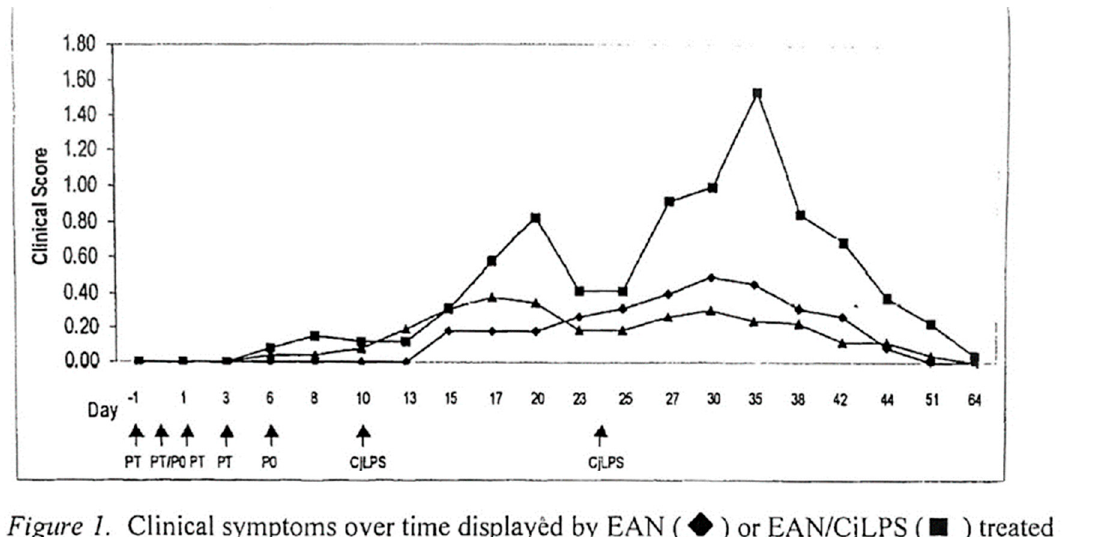
Figure 1. Experimental allergic neuritis (EAN) was induced in GM1 antibody transgenic mice (GM1Ab) by immunization with myelin PO peptide (180-199) in the presence of Freund’s adjuvant and pertussis toxin on days 0 and 6. On days 10 and 24 the mice received s.c. injections of LPS from C. jejuni 0:19 (CjLPS). Signs of neuropathy were scored from 0–6 (normal–death). Serum IgM anti-GM1 antibody were assayed by ELISA. Controls included similarly treated wild-type (WT) mice and GM1Ab mice given only EAN or CjLPS. EAN mice showed signs of peripheral neuropathy ranging from floppy tail (score 0.5–1), to moderate hind limb weakness (score 2.5). CjLPS